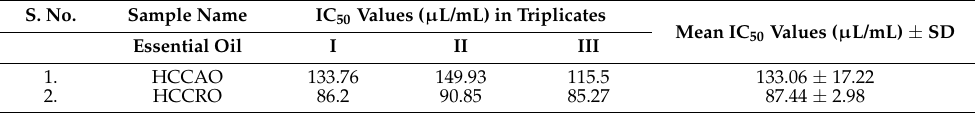
Table 13. IC 50 value of inhibition of shoot length of HCCAO and